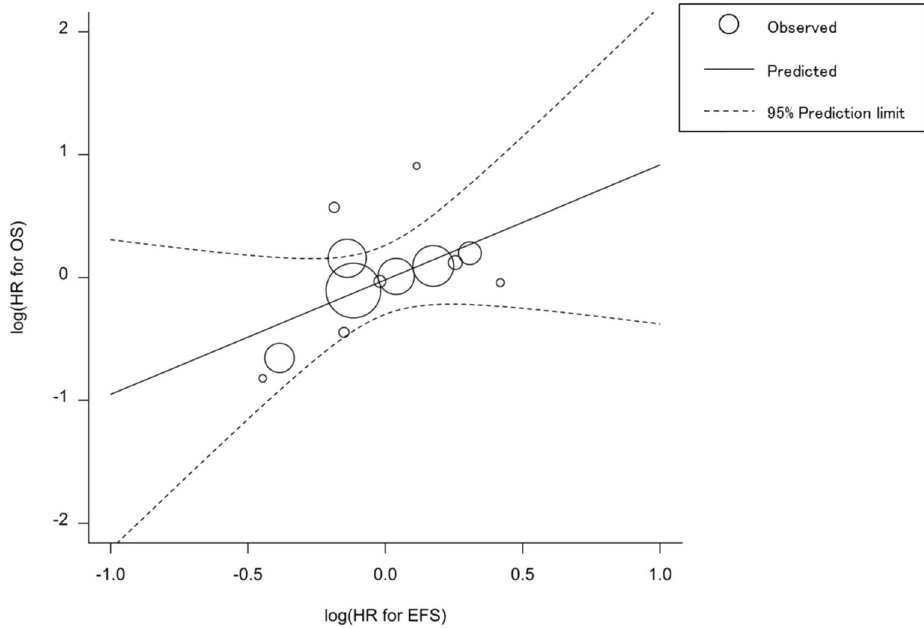
Figure 3. The trial-level association between the HR for event-free survival (EFS) and overall survival (OS).